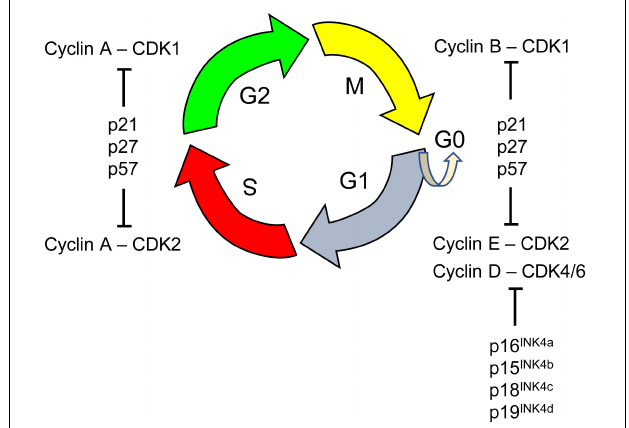
FIGURE 3 | The cell cycle is a series of events that lead to cell division. It comprises four phases: the first gap phase called G1 during which cells prepare for DNA replication, the S phase of DNA synthesis, a second gap phase called G2, and the M phase of cell mitosis in which segregation of replicated chromosomes into two separate cells occurs. Cells in G1 can, before DNA replication, enter a resting state, called G0. Progression through the cell cycle is tightly regulated by cyclin-dependent kinases (CDK 1, 2, 4, 6). CDKs are serine/threonine protein kinases that phosphorylate key substrates for DNA synthesis and mitotic progression. CDKs interact with various positive and negative cell cycle regulators. Cyclins (A, B, D, E) are positive cell cycle regulators that represent the regulatory subunits of CDKs; their binding to CDKs allows inactive CDKs adopting an active configuration, driving transition phases. Different cyclins are required at different phases of the cell cycle. For instance, D-type cyclins bind to CDK4/6 forming the active cyclin D/CDK4/6 complex that is necessary for progression through the G1 phase of the cell cycle. The G1 phase is considered a critical window during which cells decide to proliferate, assume a reversible arrest (G0), or begin a path toward terminal differentiation or senescence. The activity of CDKs can be counteracted by the CDK inhibitory protein/Kinase inhibitory protein (Cip/Kip) family, that includes p21 CIP1 (p21), p27 KIP1 (p27), p57 KIP2 (p57) and by proteins of the INK4 family. These negative cell cycle regulators inhibit cell cycle progression by binding to specific CDKs alone (INK4 family) or cyclin-CDK complexes (Cip/Kip